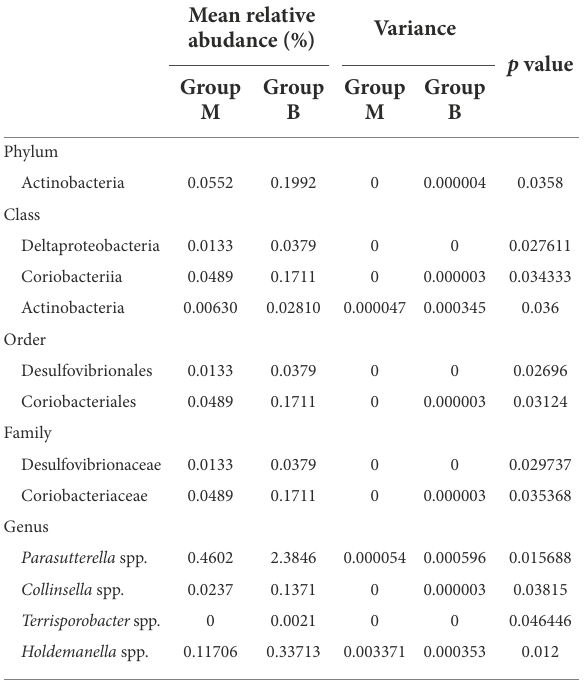
TABLE 3 Microbial strains with significant differences at each classification level between Group M and Group B. Mean relative abudance